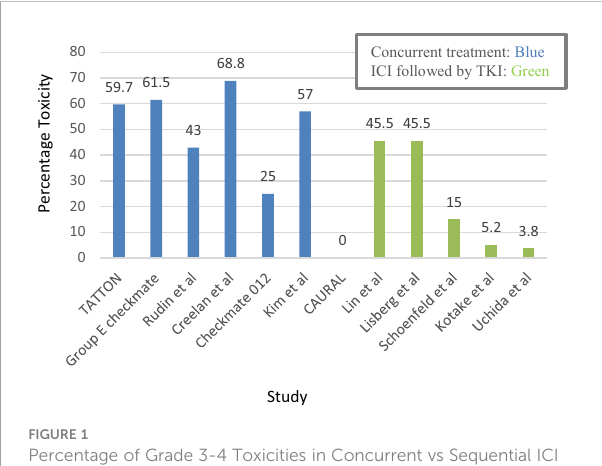
FIGURE 1 Percentage of Grade 3-4 Toxicities in Concurrent vs Sequential ICI and TKI